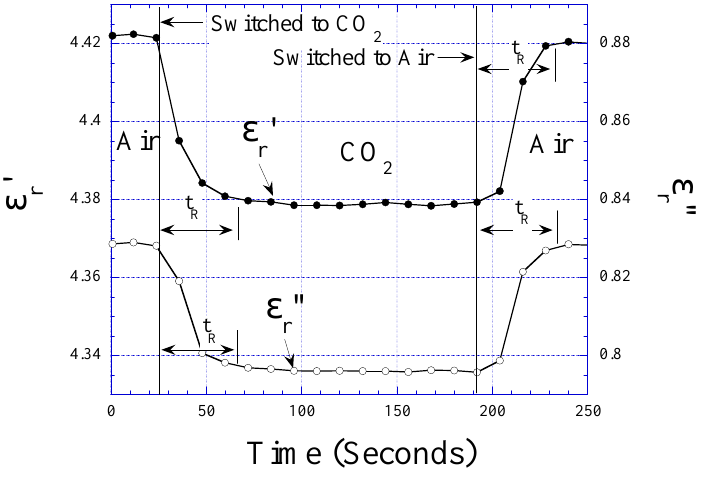
Figure 8. Change in ε The response time t